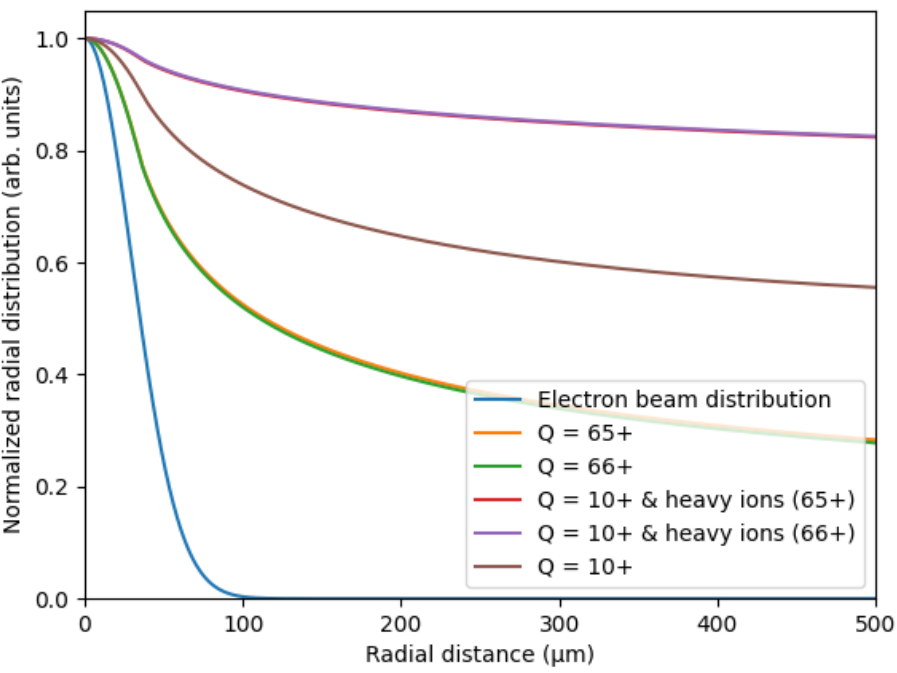
Figure 4. Boltzmann distributions of ions with charge Q = 10 + , 65 + , 66 + , 10 + with 65 + present, and 10 + with 66 + present in identical electron beam ion trap conditions (18 keV beam energy, 150 mA beam current, and 70% neutralization with all ions in thermal equilibrium at a temperature of 20